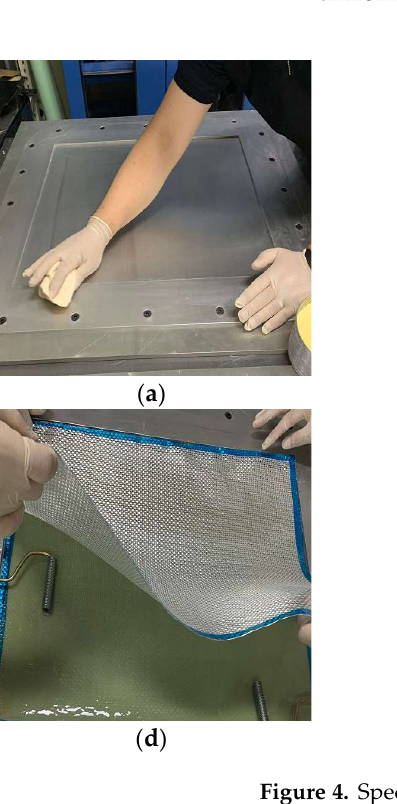
Figure 4. Specimen fabrication by hand lay-up method. ( a ) Surface release treatment. ( b ) Mixing resin. ( c ) Inner lamination of peel ply. ( d ) Fabric lamination. ( e ) Adhesive impregnation by hand rolling. ( f ) Lamination of peel ply and release film.